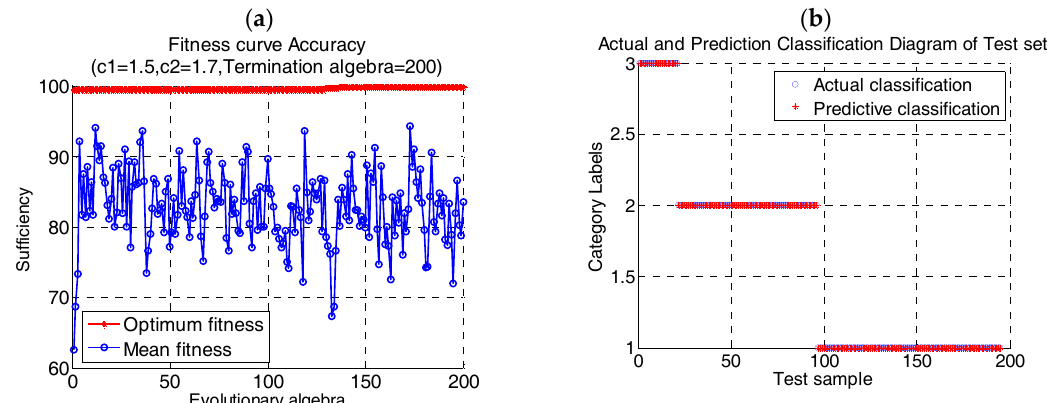
Figure 9. Clustering results of Lymphocyte ( a ) Fitness curve ( b ) Clustering results.